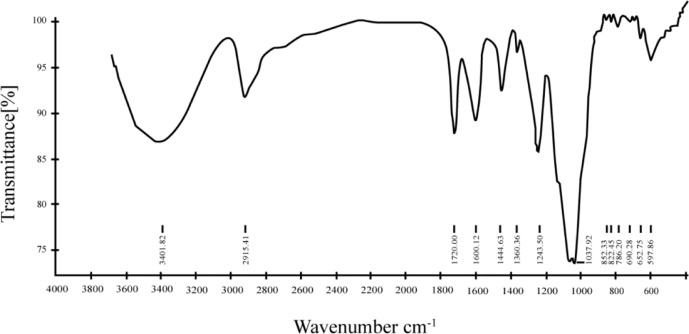
Fourier-transform infrared (FT-IR) spectra of AAP1 in the range of 400–4000 cm-1.